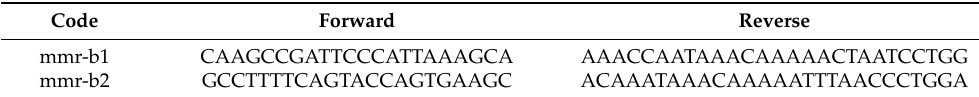
Table 2. Primers used for the analysis of mmr-b